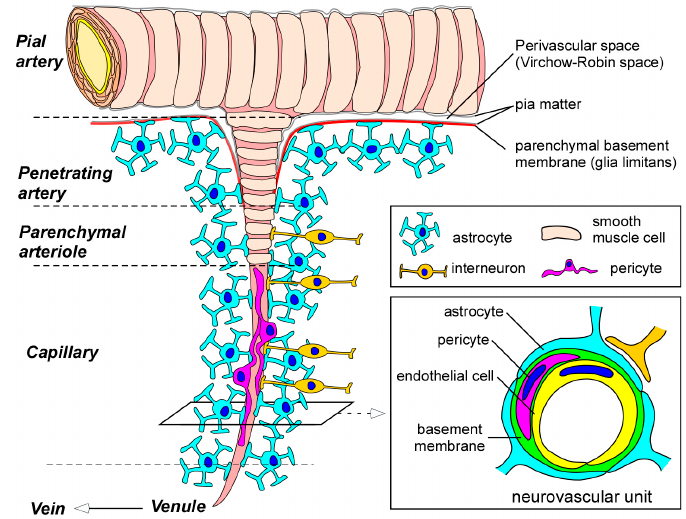
Figure 1. Blood-brain barrier (BBB) and the neurovascular unit. Pial arteries branch out into smaller arteries called penetrating arteries. The penetrating arteries go further down into the brain parenchyma, giving rise to parenchymal arterioles, which eventually branch off into capillaries. Whereas pial and penetrating arteries are covered by vascular smooth muscle cells and are separated from brain tissues by the parenchymal basement membrane (glia limitans), parenchymal arterioles and capillaries become associated with neurons and astrocytes. Parenchymal arterioles are covered by one layer of smooth muscle cells. In capillaries, endothelial cells form the BBB. BBB properties in endothelial cells are further maintained and regulated through communications with basement membranes and other neighboring cells in neurovascular unit such as pericytes, astrocytes, and interneurons. BBB indicates blood-brain barrier.